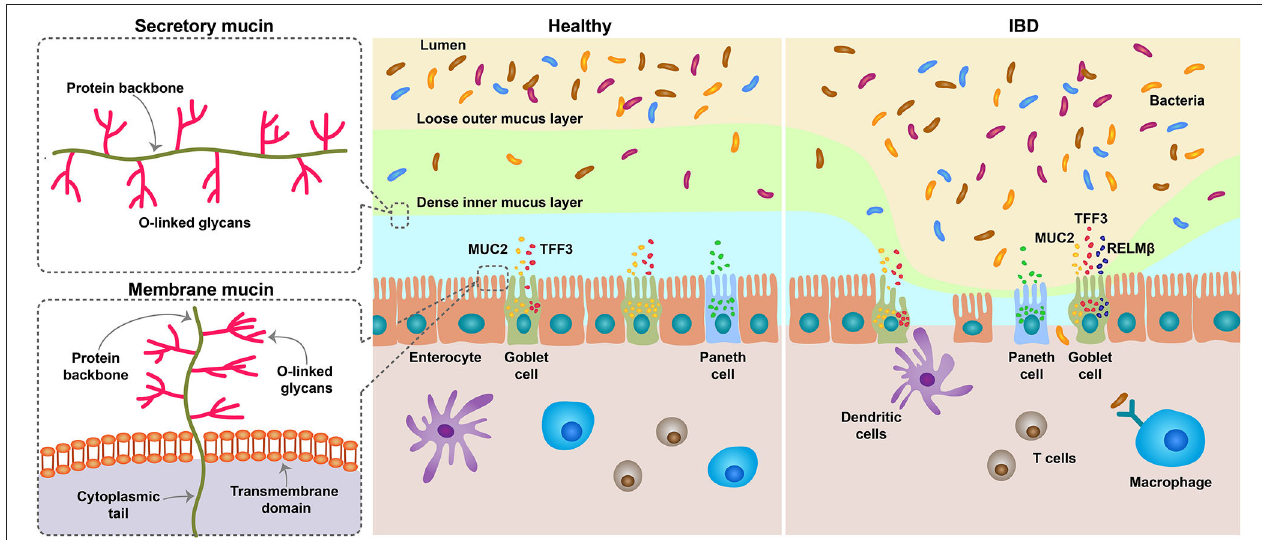
FIGURE 1 | Schematic diagram depicting the role of MUC2 in IBD. The mucous membrane consists of two layers, a loose outer layer, which is permeable to bacteria, and a tightly attached inner layer, which cannot penetrate. Mucins are produced by goblet cells of the intestinal epithelium and are divided into secretory and membranous types. Secreted mucins are gel-forming mucus, composed mostly of MUC2, and provide viscoelasticity. Although the degradation and synthesis of mucin are generally in equilibrium, the number of goblet cells is reduced in the IBD state, and thus the secretion of mucin is also reduced. It also increases the number of immature goblet cells that produce incomplete mucus. When the mucous membrane breaks down, the bacteria in the lumen penetrate inside and cause inflammation. MUC, Mucin; IBD, inflammatory bowel